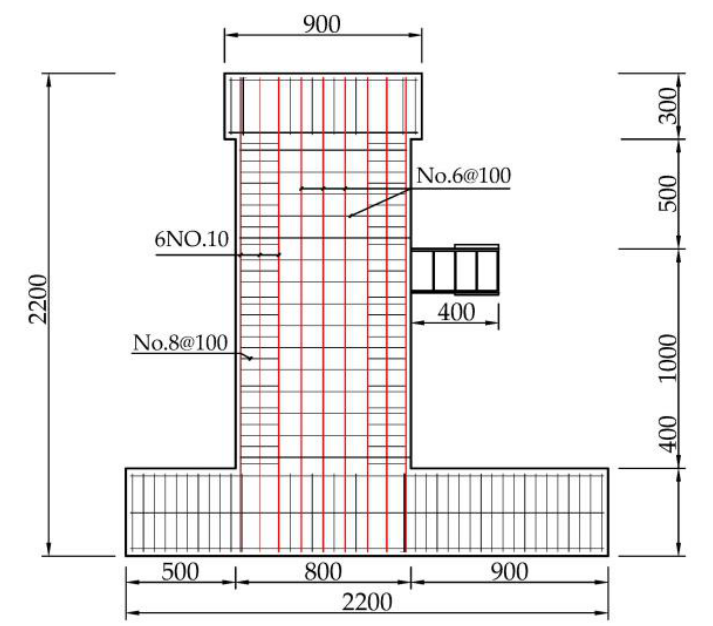
Figure 3. Overall dimensions of subassemblies (unit: mm).